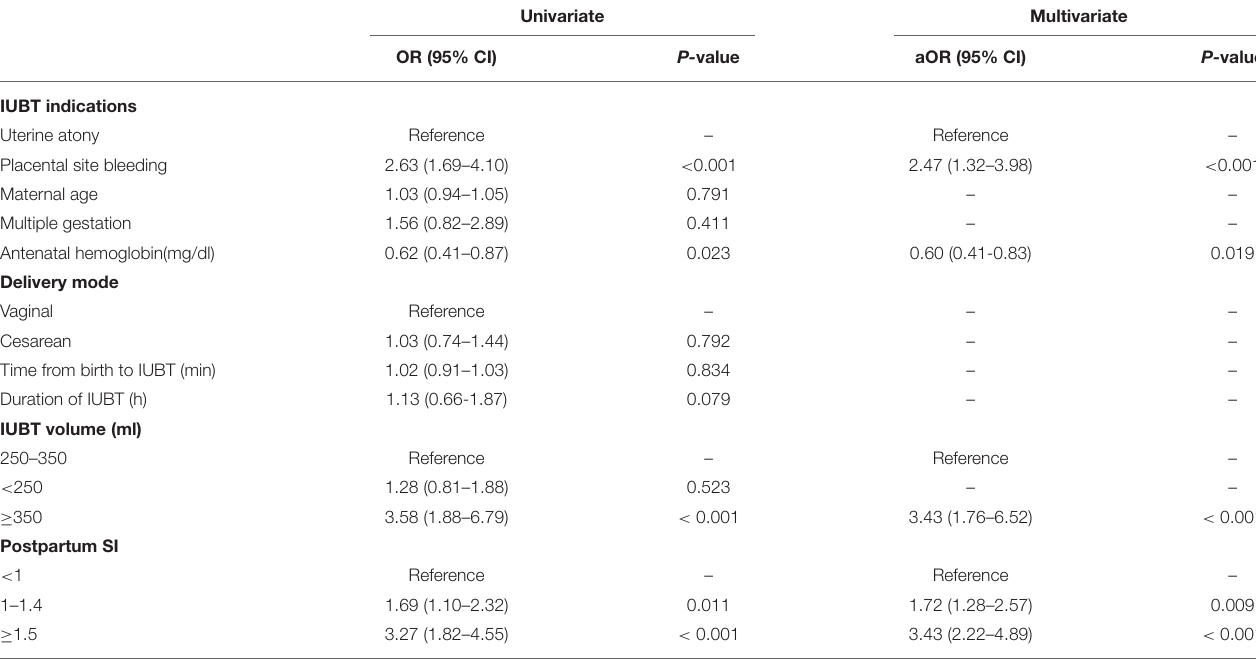
TABLE 3 | Risk factors for the prevalence of transfusion ≥ 4 units of